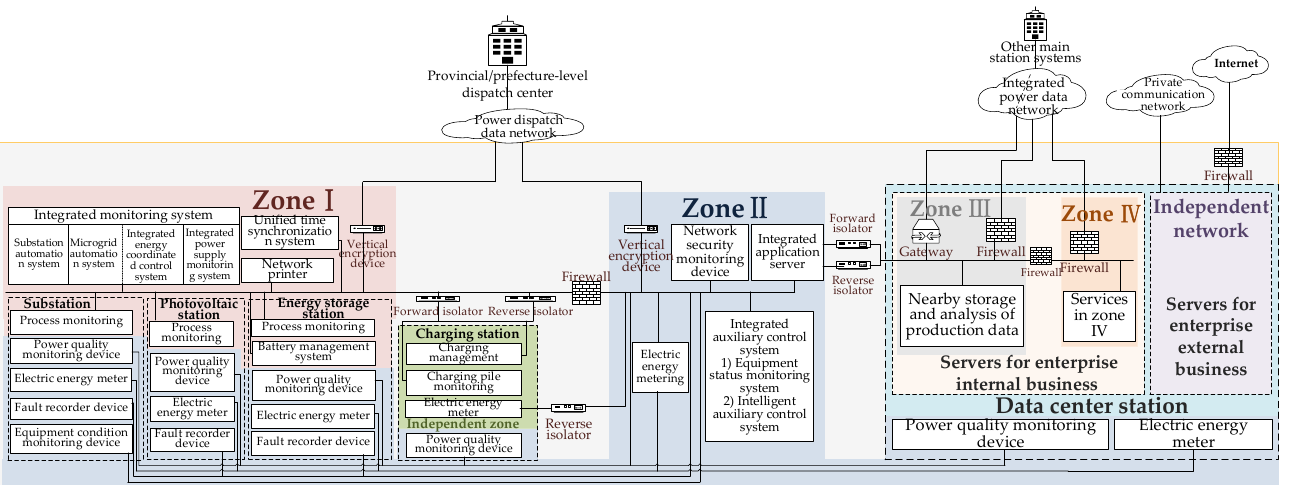
Figure 6. Security zoning and isolation of SESt.